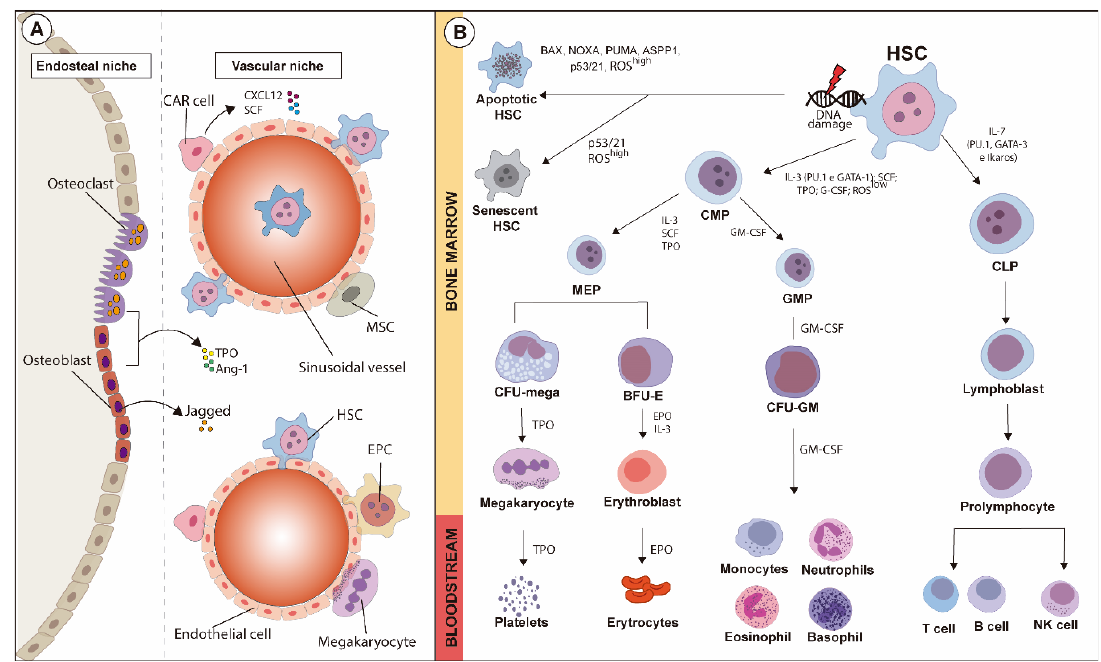
Figure 1. Schematic overview of HSC niches and fate-decision of hematopoietic lineages during hematopoiesis, along with the major transcription factors and cytokines involved. ( A ) HSC niches comprise endosteal and vascular regions containing several cell types. In the endosteal niche, osteoclasts and osteoblasts, as well as other cell types, support the vascular niche where mesenchymal stromal cells (MSCs), hematopoietic stem cells (HSCs) and CXCL12-abudant (CAR) cells are anchored. The maturation of hematopoietic lines is modulated by the fine balance between both niches. ( B ) Hematopoietic stem cells (HSCs) can undergo either apoptosis or senescence after suffering oxidative stress or DNA damage, which might or might not activate apoptotic pathways. Under physiological status, activation of GATA-1 and PU.1, low levels of reactive oxygen species (ROSs), and modulation exerted by soluble factors such as IL-3, SCF, TPO and G-CSF in HSCs give rise to common myeloid progenitors (CMPs), which then originate neutrophils, eosinophils, basophils and monocytes. On the other hand, common lymphoid progenitors (CLPs), under influence of IL-7, are modulated by the activation of GATA-2, Ikaros, and PU.1. CMPs originate erythrocytes and platelets after the maturation of intermediary precursors, and CLPs mature into B and T lymphocytes and natural killer cells.